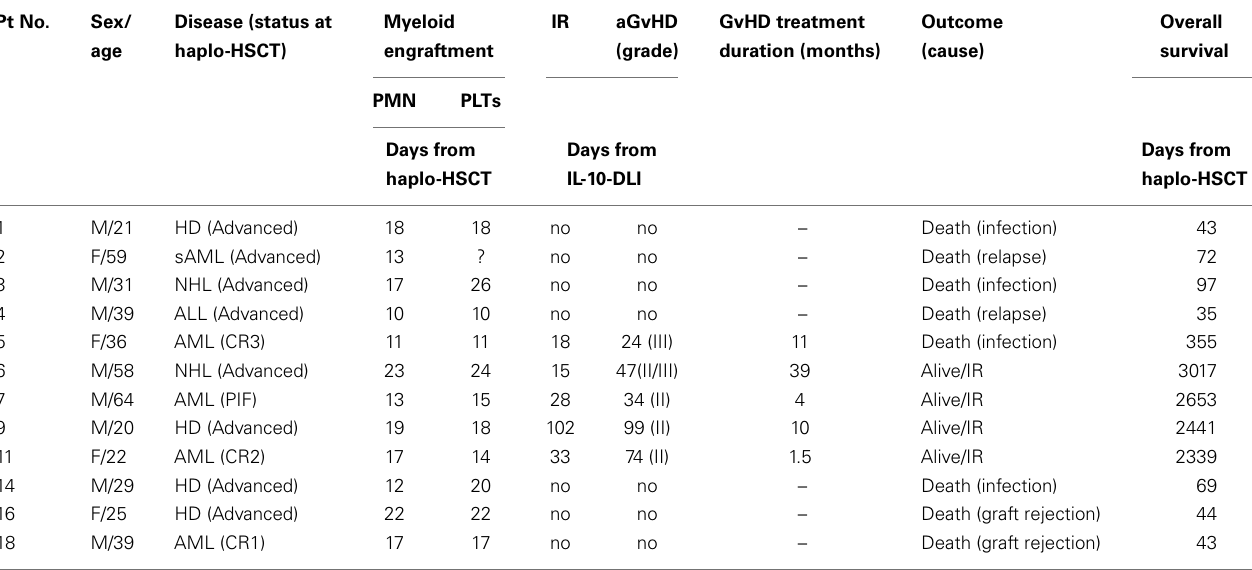
Table 1 | Outcome of the IL-10-DLI treated patients . Pt No.